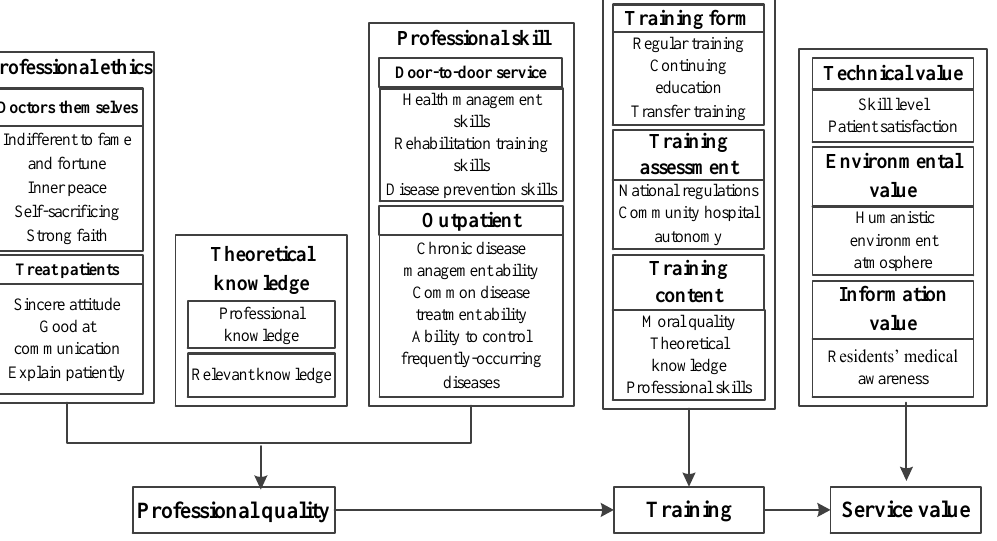
Figure 1. The training path model of general practitioners’ professional quality to its service value.